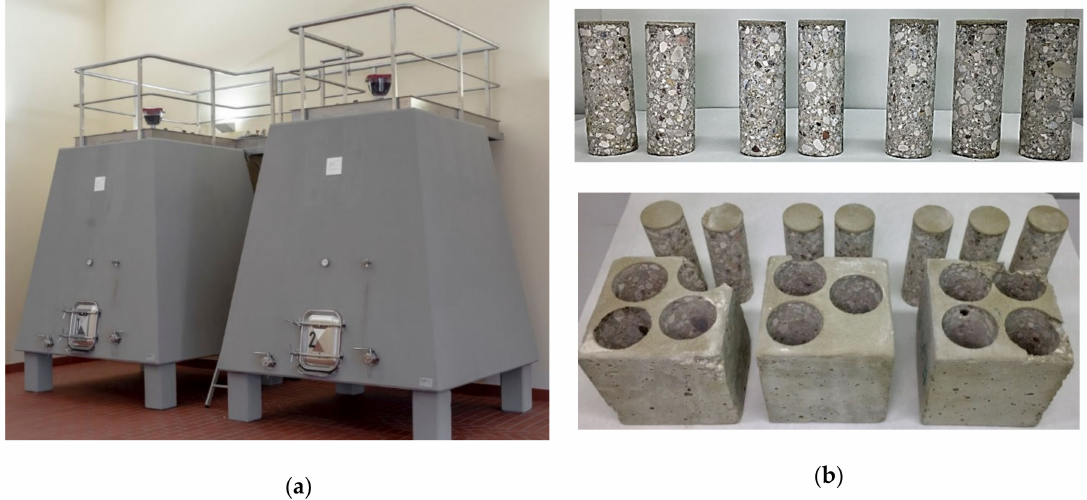
Figure 7. View of ( a ) concrete tanks (DVTec, France) and ( b ) pieces extracted for testing next to the concrete blocks supplied.